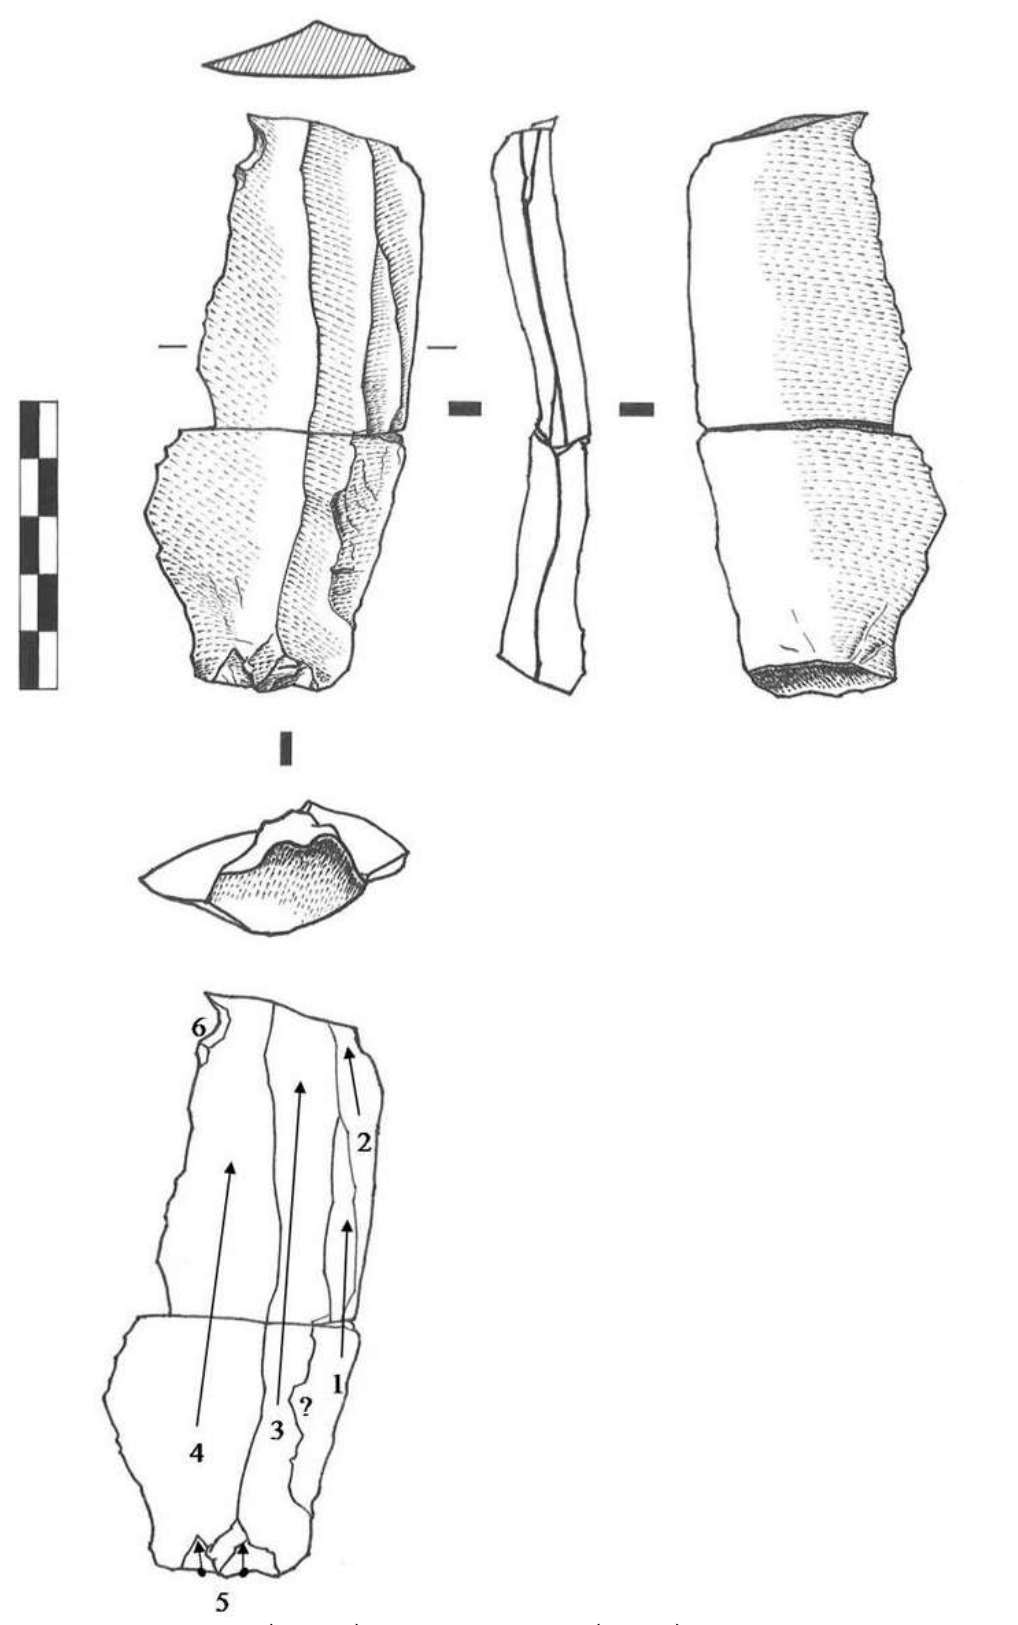
Figure 6. Technological drawing (superior) and diacritic scheme (inferior) of blade refitted with broken blade PCO025-a (bottom fragment) and blade fragment PCO025-b (top fragment). Arrows indicate interpreted direction of the flaking and numbers indicate the order of